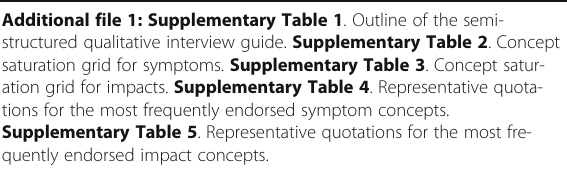
Additional file 1: Supplementary Table 1 . Outline of the semi- structured qualitative interview guide. Supplementary Table 2 . Concept saturation grid for symptoms. Supplementary Table 3 . Concept satur- ation grid for impacts. Supplementary Table 4 . Representative quota- tions for the most frequently endorsed symptom concepts. Supplementary Table 5 . Representative quotations for the most fre- quently endorsed impact